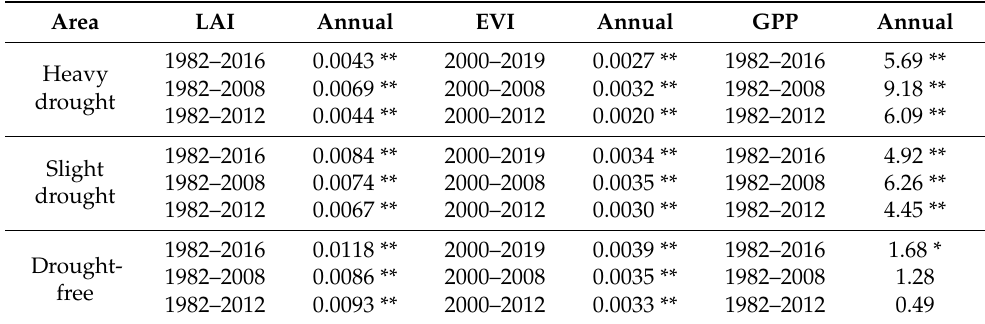
Table 2. The trend before the drought (BDT), after the drought (ADT), and the long-term trend (LTT) of vegetation